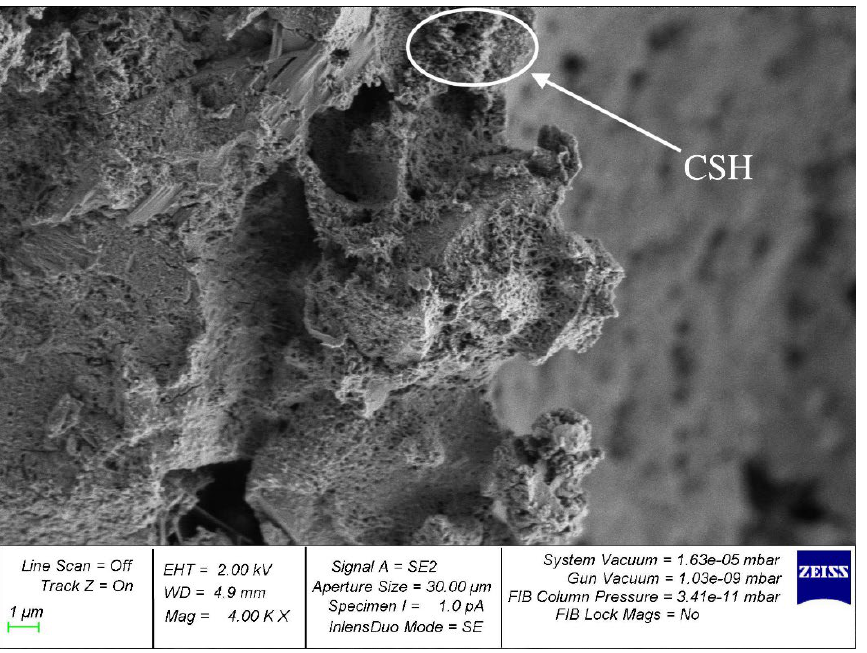
Figure 18. SEM image of the structure of an electromagnetically treated hardened cement paste with 15% RSA in place of part of the cement.